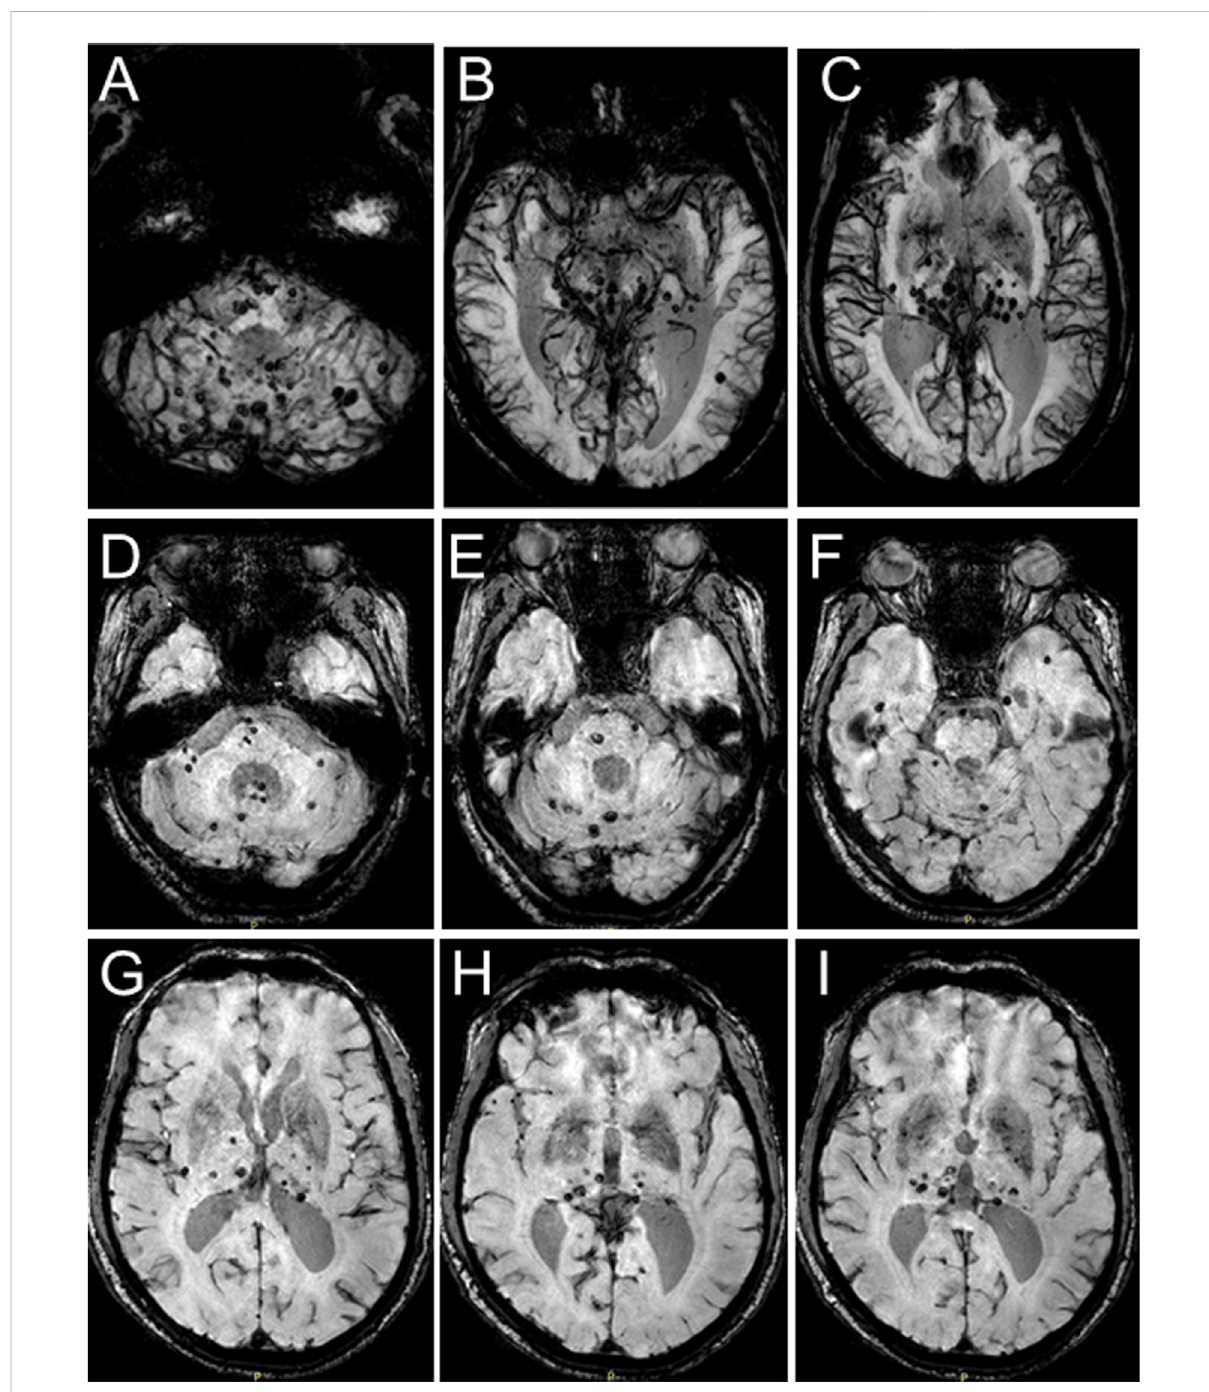
FIGURE 2 Brain MRI-SWI images of the proband. SWI images present with multiple hypointense signal intensities at several brain levels and demonstrate multiple foci of hemorrhage in the proband ’ s